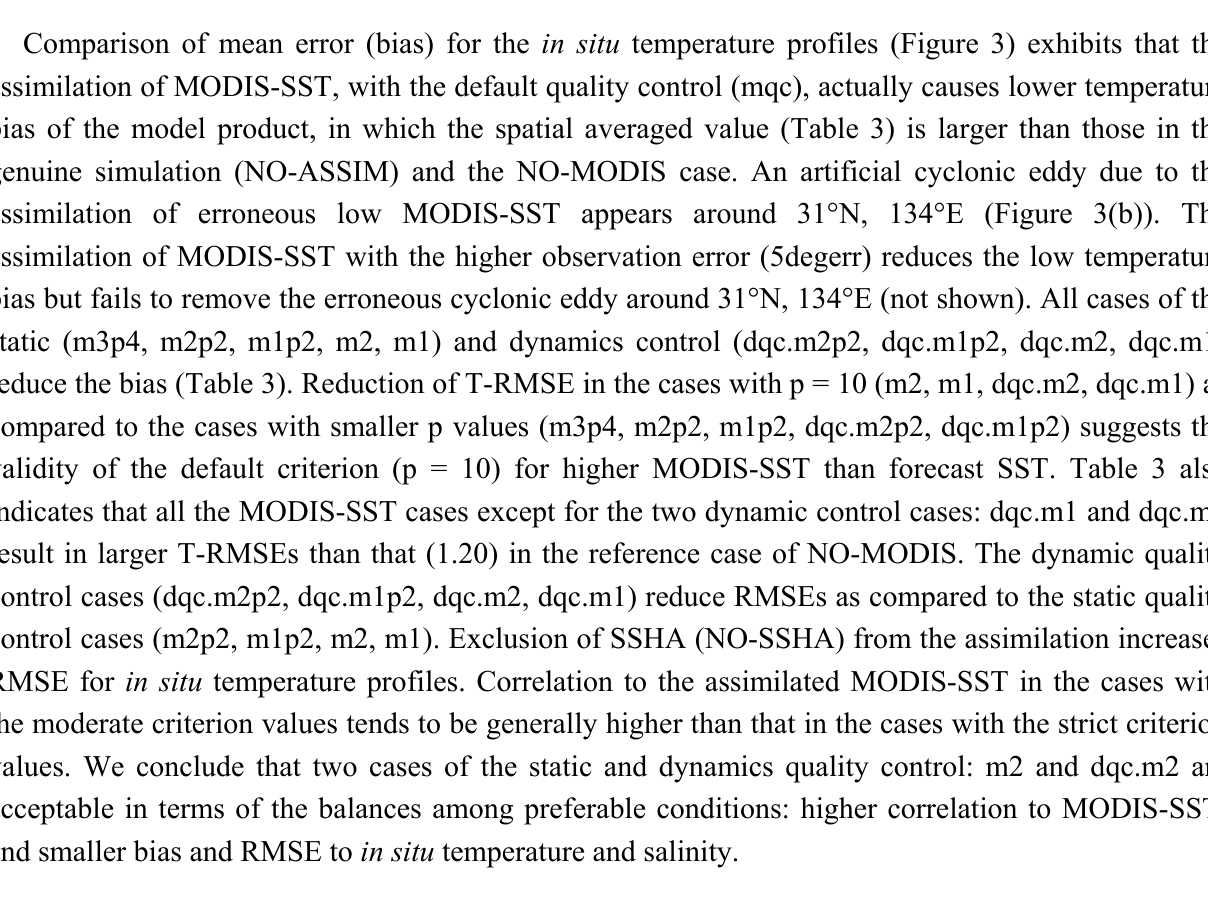
Table 3. Averaged BIAS and RMSE of model experiments for the in situ temperature and salinity